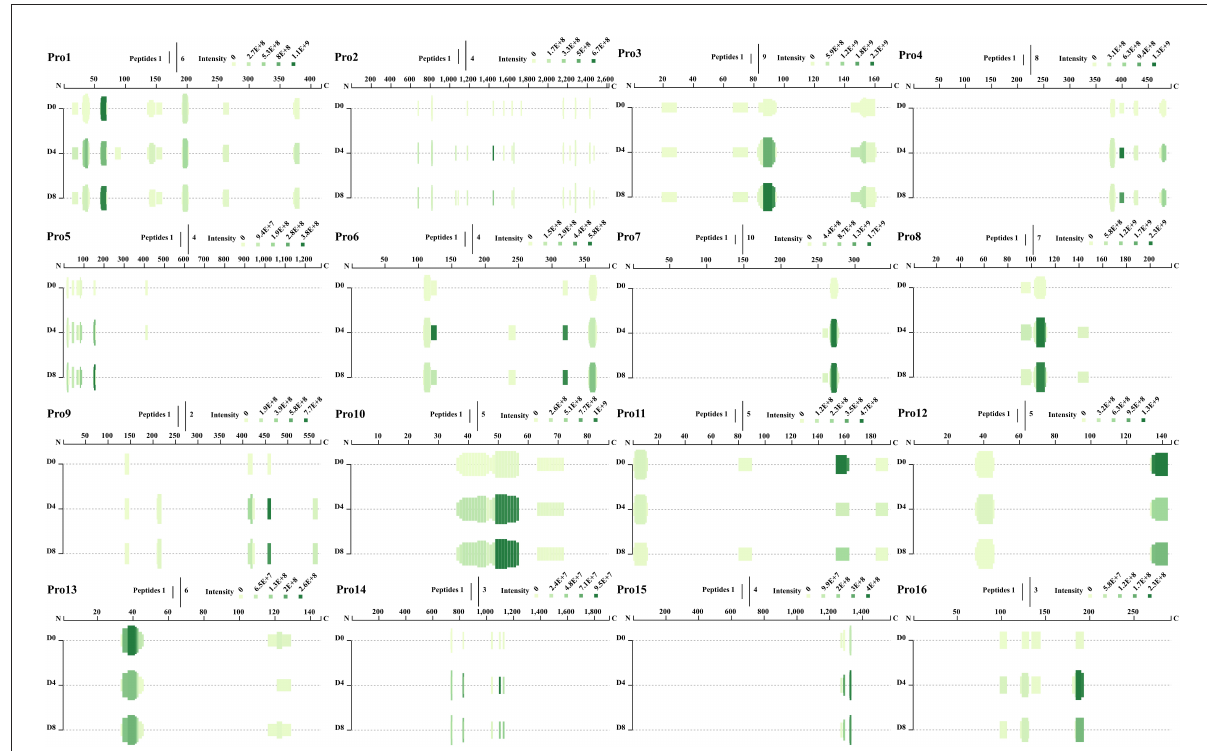
FIGURE2 Angiotensin I converting enzyme inhibitory peptide profile of representative precursor proteins (Pro1–Pro16) during fermentation of Chouguiyu